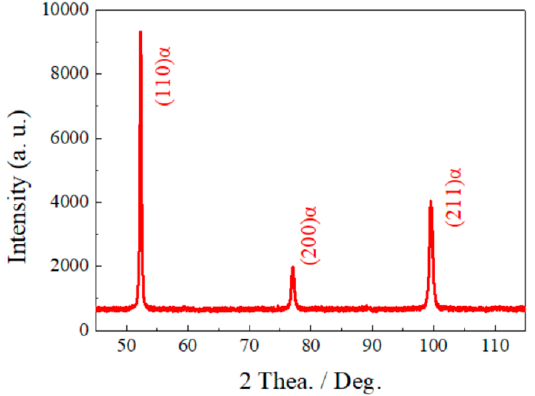
Figure 6. XRD pa tt ern of X100 high-grade pipeline